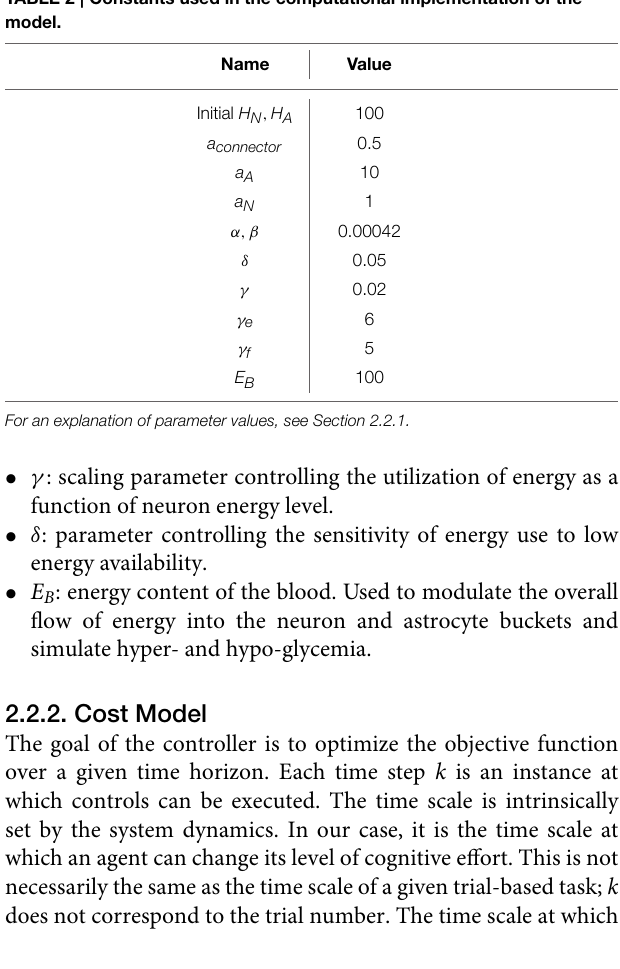
FIGURE 2 | Visual display of the relationship between control/neuromodulation ( u ), energy availability ( H N ), energy use ( E use ), neural recruitment [ NeuralRecruit ( x , u ) ], and performance [ Perf ( x , u ) ]. Curves were generated using the equations from Equation (5) and parameters from Table 2 . (A) The relationship between control/neuromodulation and energy utilization is modeled as linear, with the slope controlled by the amount of